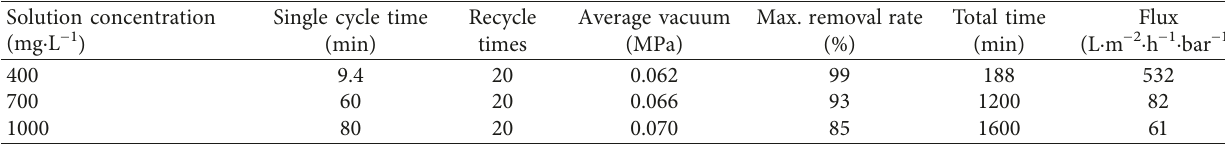
Table 6: Adsorption capacity of the ZIF-8/GO film.